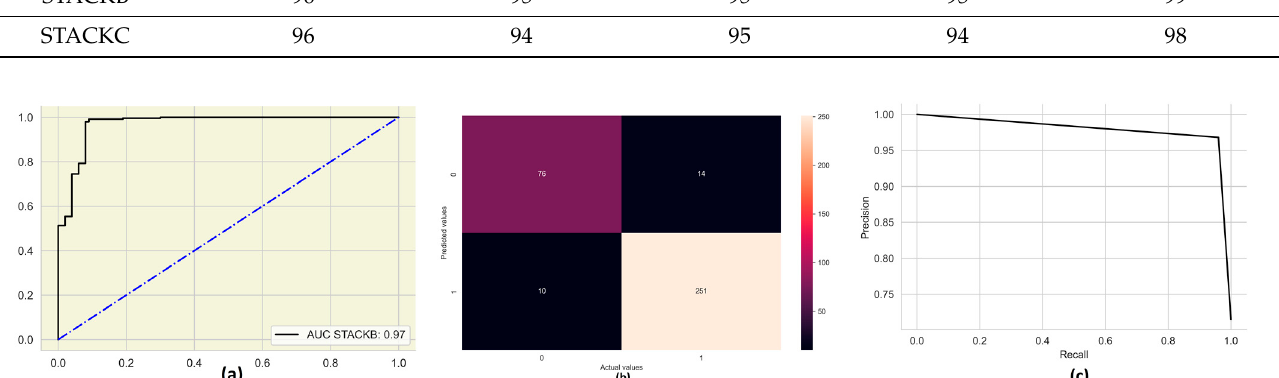
Figure 6. AUC’s and confusion matrices obtained by STACKA, STACKB and STACKC (Stacked models). ( a ) AUC ( b ) Confusion matrix ( c ) Precision-Recall curve.